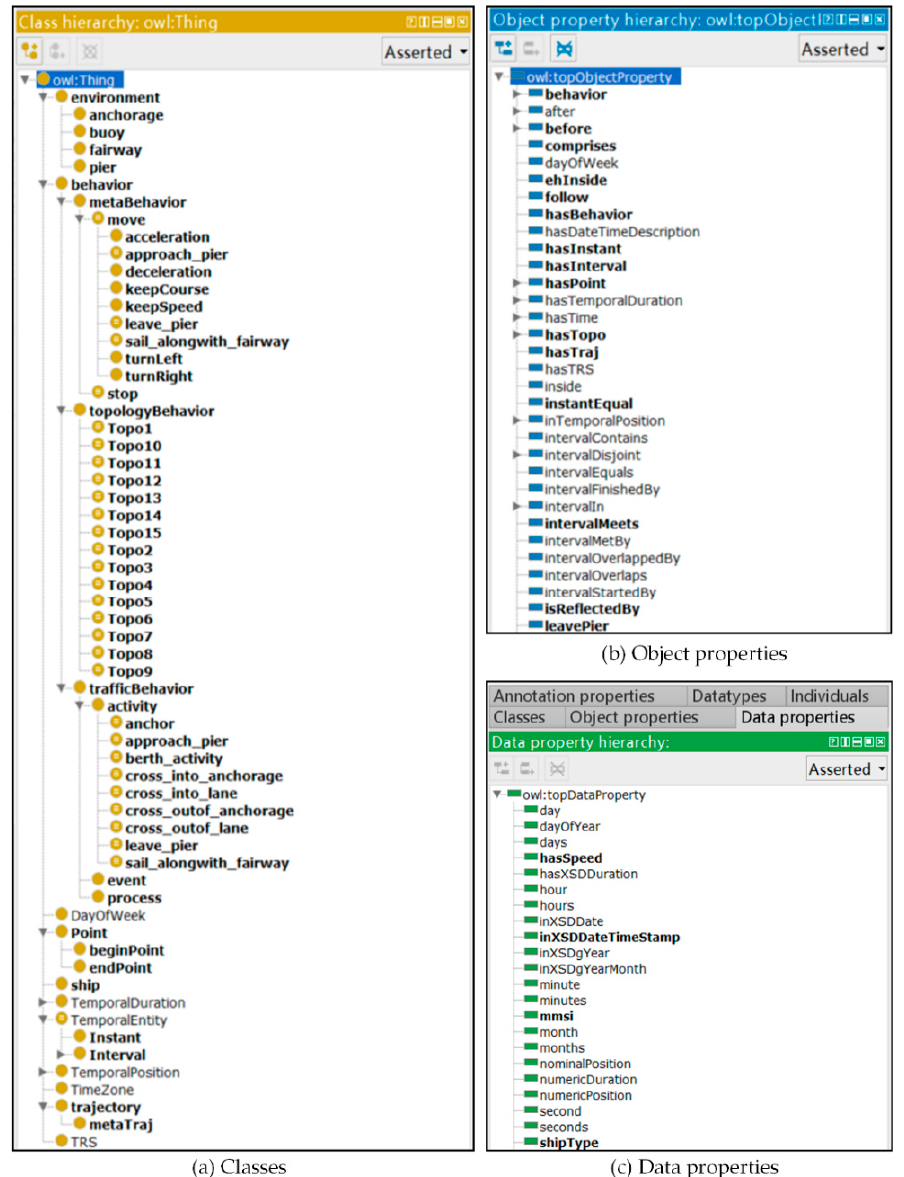
Figure 3. Ontology model of cognition for ship behavior.